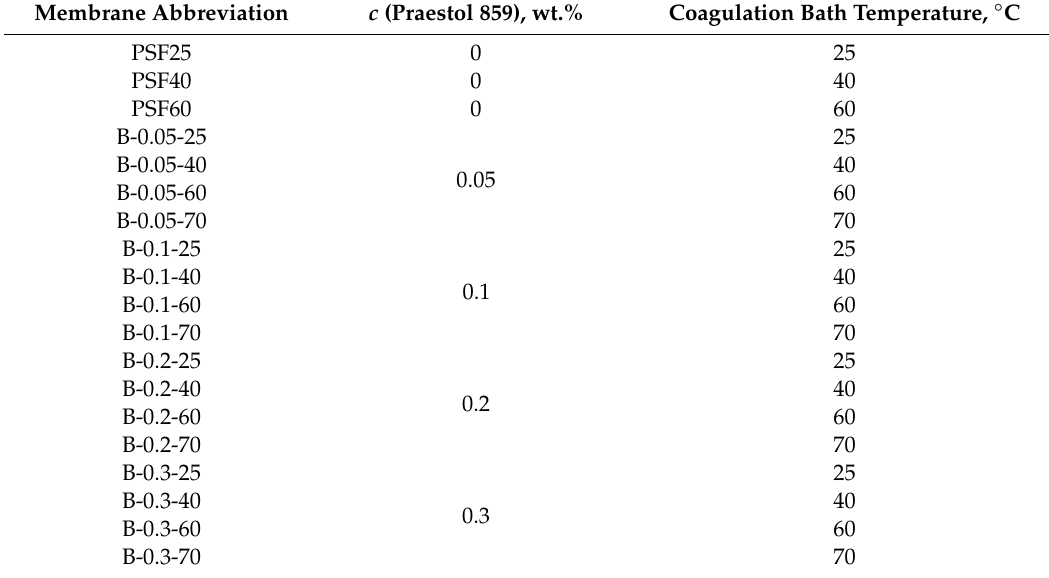
Table 1. Conditions for membrane